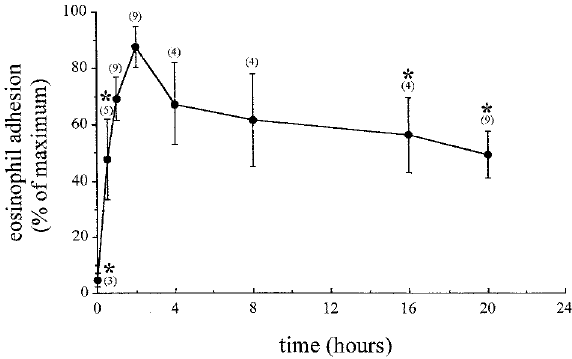
FIG. 1. Eosinophil adhesion to airway smooth muscle cells after various periods of co-culture. Values are means ± SE; ( n ), number of experiments; *, significantly different from